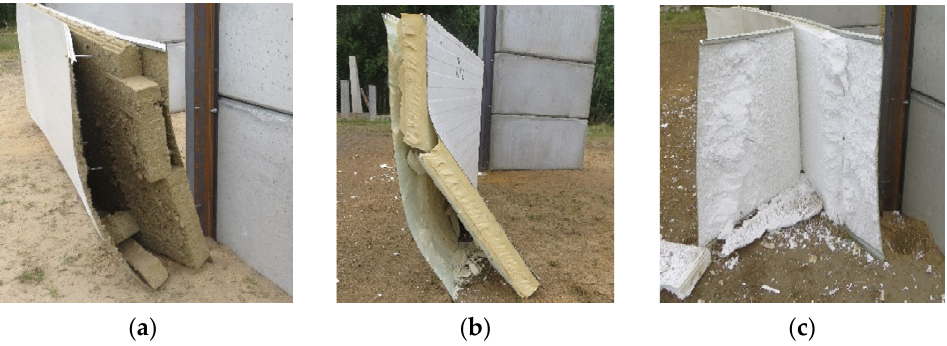
Figure 10. Comparison between the shear failure at the supports of the sandwich panels when using different core materials: ( a ) mineral wool; ( b ) polyisocyanurate foam; and ( c ) expanded polystyrene.